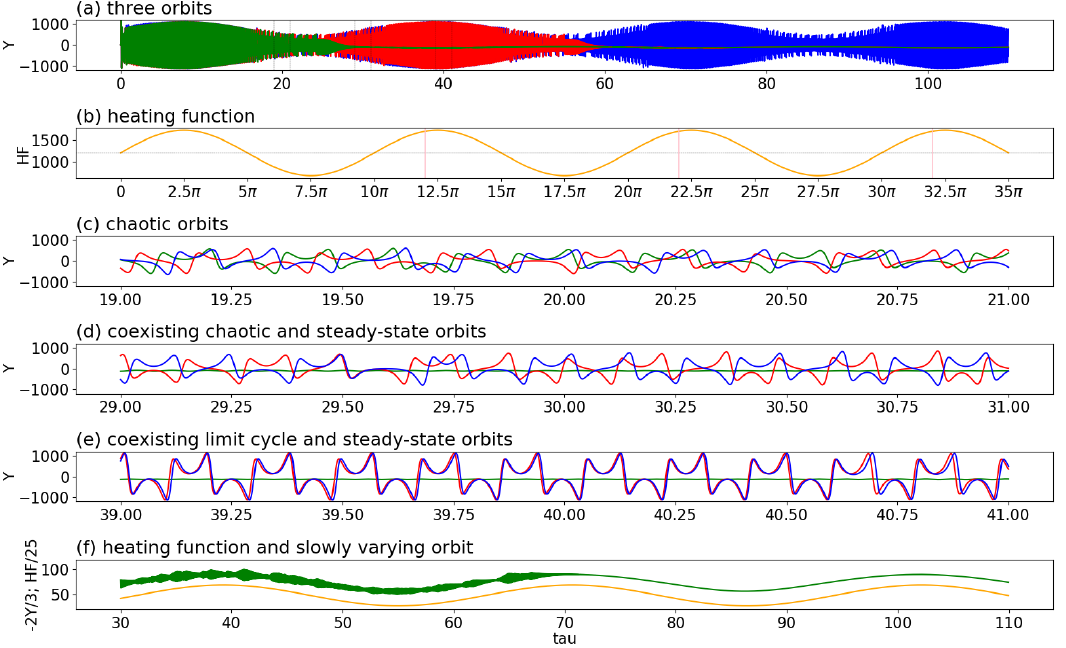
Figure 5. Two kinds of attractor coexistence revealed by three trajectories using a time varying heating parameter (i.e., Rayleigh parameter), r = 1200 + 520 sin (τ/5), within a GLM (Shen, 2019 [18]). The green, blue, and red lines represent the solutions of the control and two parallel runs. The parallel runs include an initial tiny perturbation, 𝜖 = 10 −8 or 𝜖 = −10 −8 . The heating function is indicated by an orange line. From top to bottom, panels ( a , b ) display the three orbits and the heating param- eters for τ ∈ [0, 35π], respectively. Panel ( c ) for τ ∈ [19,21] displays diverged trajectories, showing SDIC. The first kind of attractor coexistence (i.e., coexisting chaotic and steady-state solutions) is shown in panel ( d ) for τ ∈ [29,31]. The green line, indeed, represents a steady state solution. The second kind of attractor coexistence (i.e., coexisting regular oscillations and steady-state solutions) is shown in panel ( e ) for τ ∈ [39,41]. Panel ( f ) displays a nearly steady-state solution (2Y/3) and the heating function for τ ∈ [30,110]. The three vertical lines in panel ( b ) indicate the starting time for the analysis in Figure 6. (After Shen et al., 2021 [9]).